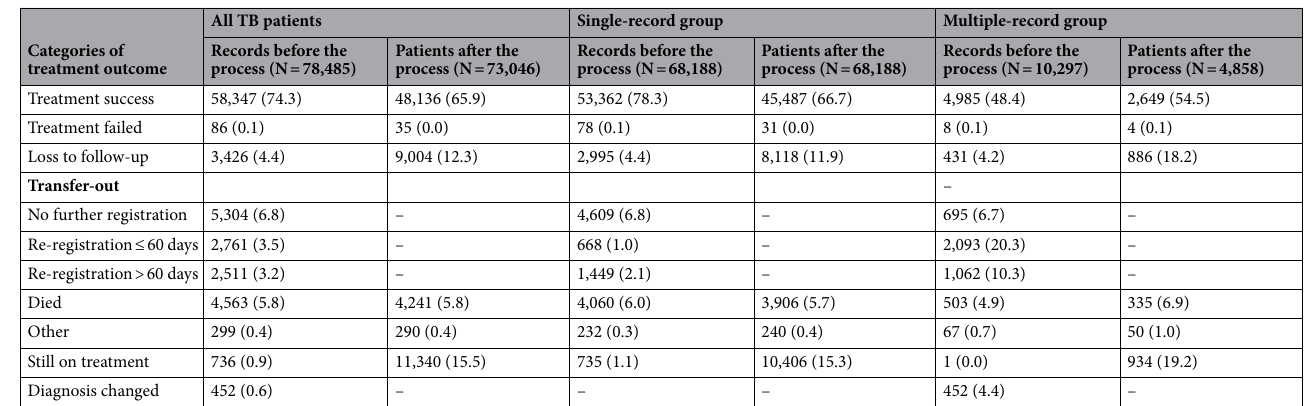
Table 1. Treatment outcomes for tuberculosis patients at before and after the process of merging and reclassifying records. Data are presented as n (%). TB